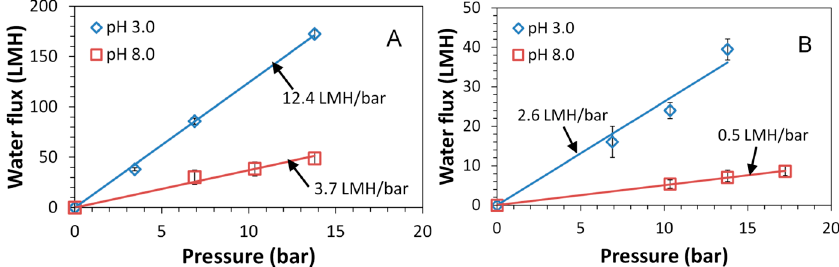
Figure 12. pH responsive flux behavior of spongy membranes L-SPVDF-PAA ( A ) and N-SPVDF-PAA ( B ). Flux tests were performed in a dead end filtration cell and pH is adjusted using 0.1 M HCl and NaOH.